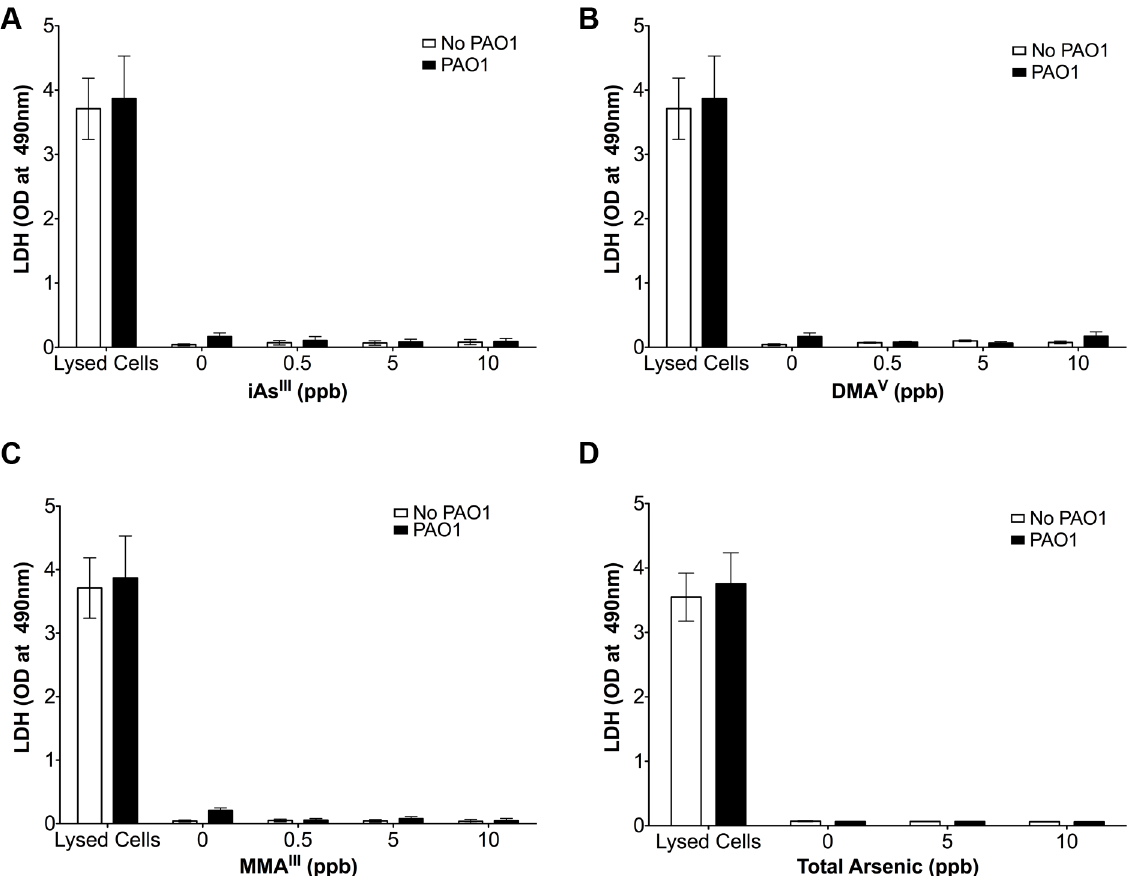
Fig 1. Arsenic exposure does not cause cytotoxicity. LDH release by HBEC was used to assess arsenic cytotoxicity and was measured using the Promega CytoTox 96 Non-Radioactive Cytotoxicity assay per manufacturers instructions. Data reported as optical density (OD, at 490 nm) of the cell culture medium bathing 500K cells. The first two bars represent LDH released by cells lysed by Triton-X (Lysed Cells). Data presented as mean ± SEM. LDH release was not significantly different from 0 in vehicle and arsenic treated cells, with and without P . aeruginosa exposure. n = 4 donors per treatment group.